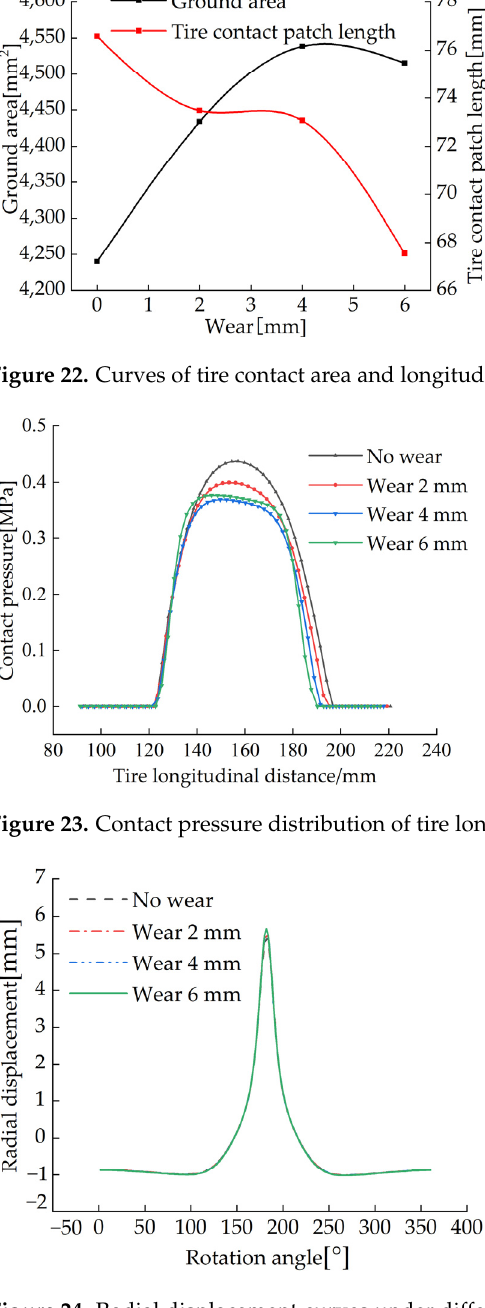
Figure 24. Radial displacement curves under different wear amounts.